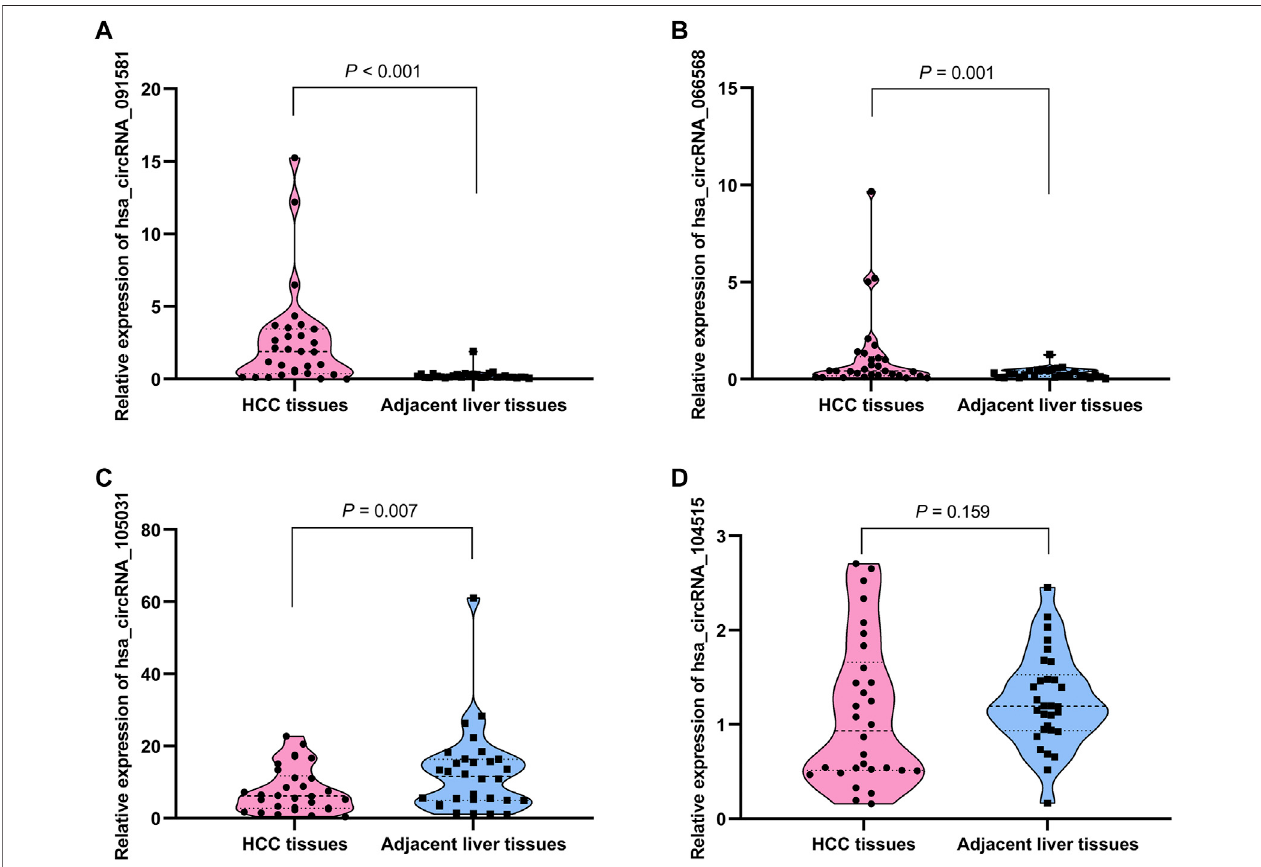
FIGURE 7 | The relative expression levels of the four circRNAs in 30 pairs of HCC tissues and their corresponding adjacent normal liver tissues by qRT-PCR. (A) hsa_circRNA_091581. (B) hsa_circRNA_066568. (C) hsa_circRNA_105031. (D) hsa_circRNA_104515. qRT-PCR, quantitative real-time polymerase chain reaction.